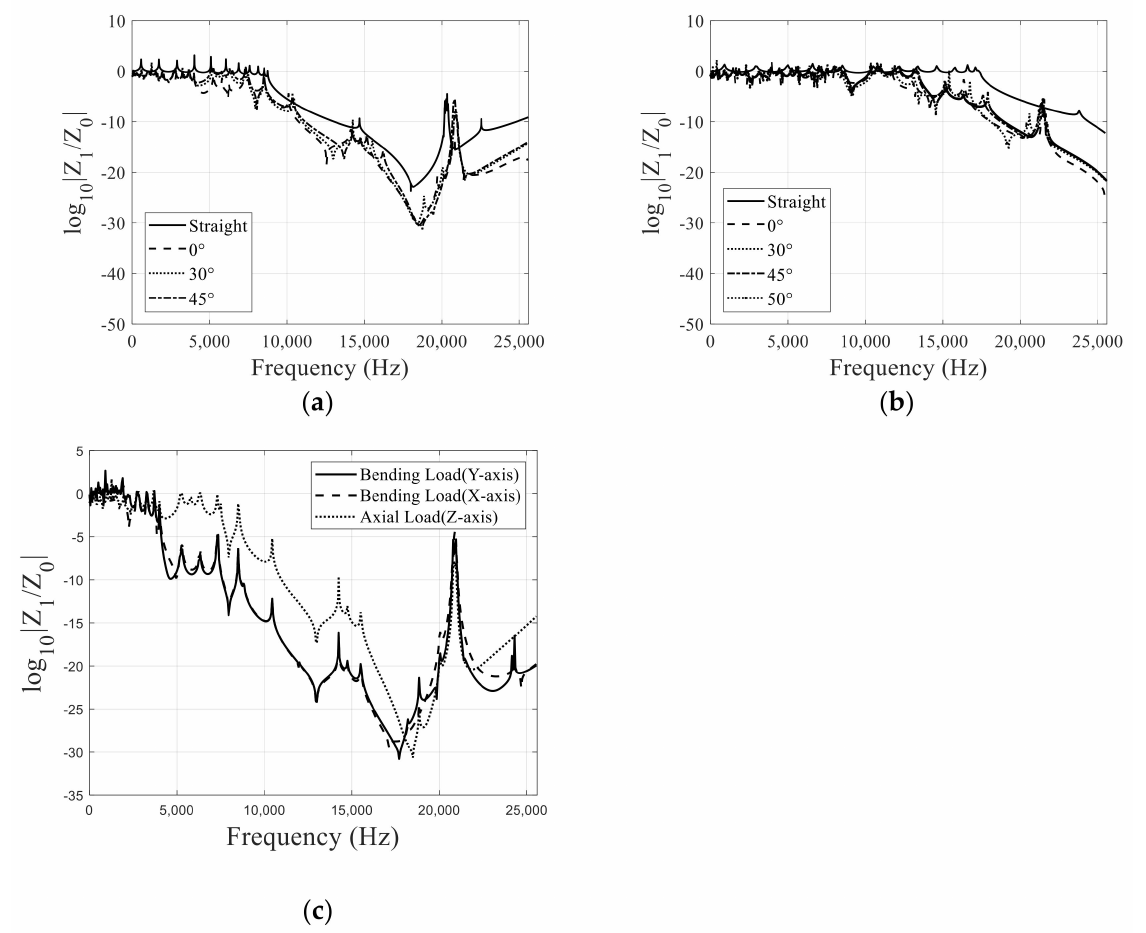
Figure 14. Frequency responses of ( a ) the curved cylindrical metamaterials, ( b ) the curved conical metamaterials and ( c ) the frequency responses for the bending loads in x and y directions ( θ = 30 ◦